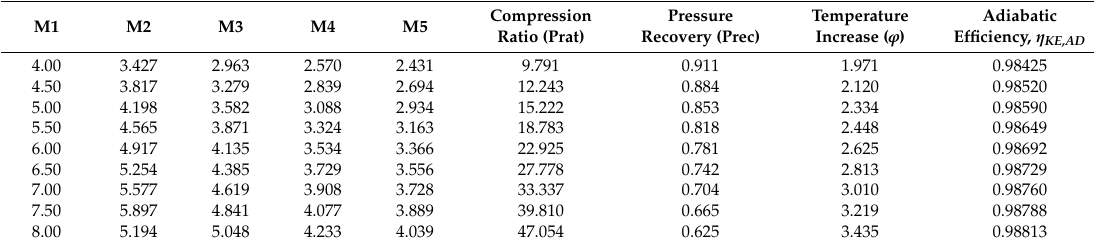
Table 4. Theoretical calculations for four ramp